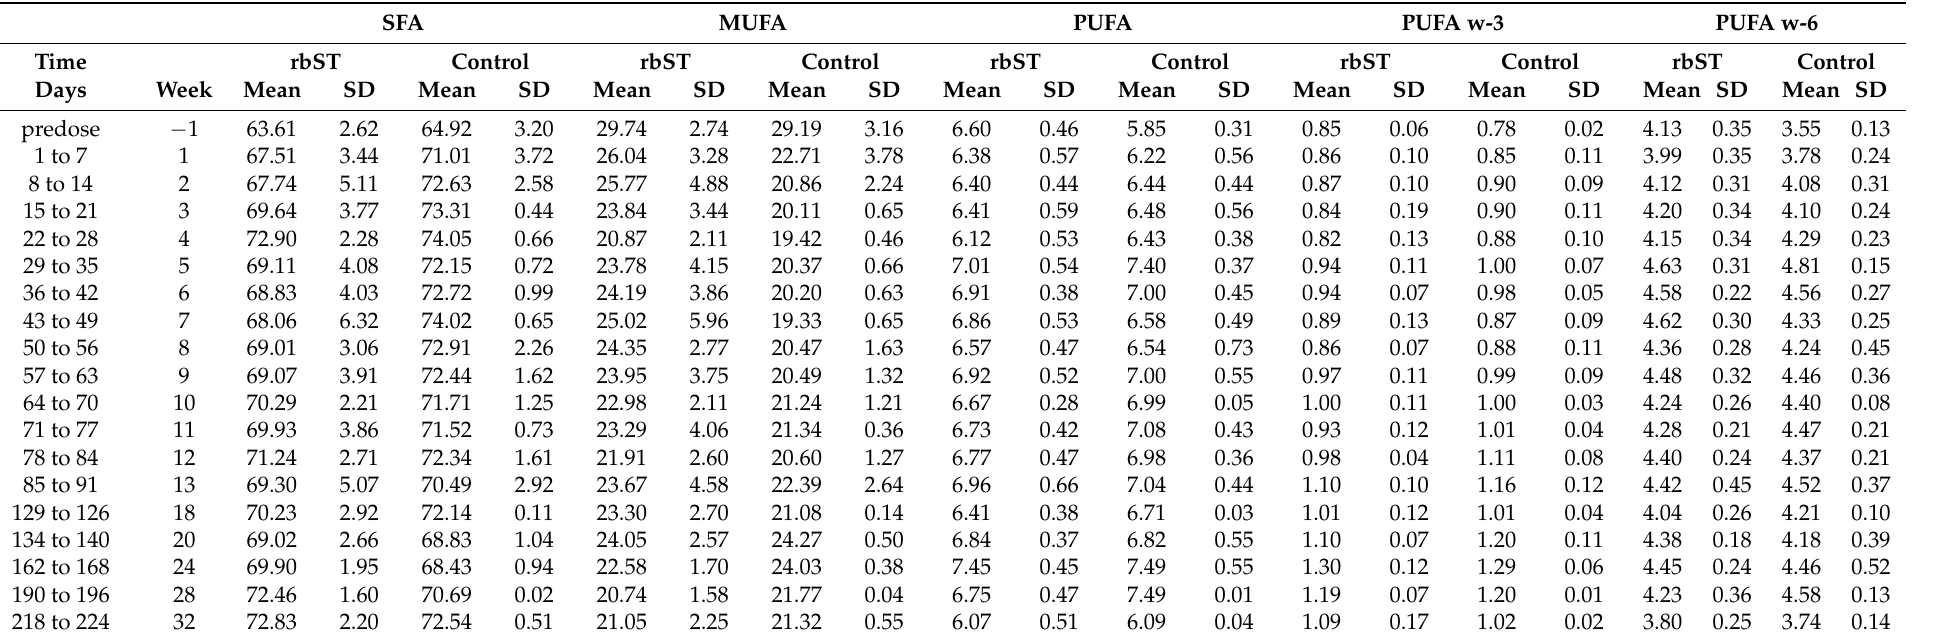
Table 8. Fat fractions in milk (% w / w of total fatty acids), i.e., saturated fatty acids (SFAs), monounsaturated fatty acids (MUFAs), polyunsaturated fatty acids